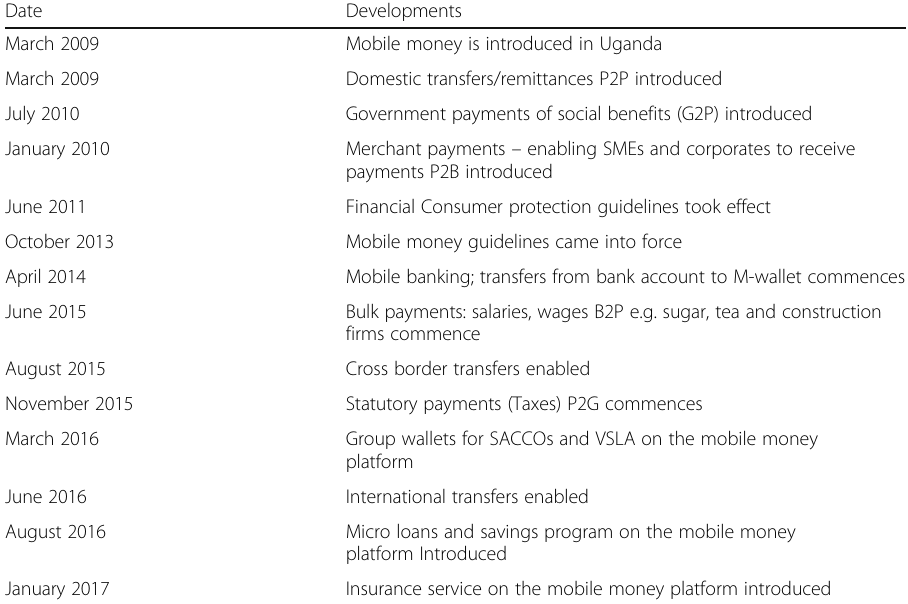
Table 1 The evolution of mobile money in